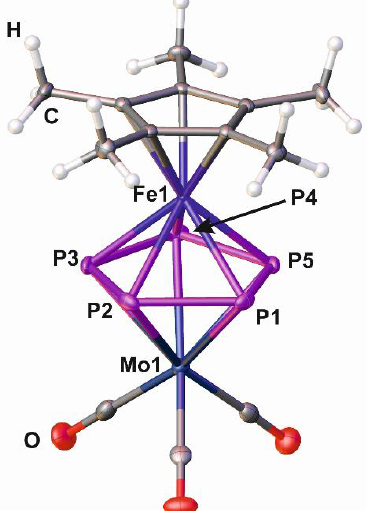
Figure 1. Molecular structure of 2’ in the solid state. Selected bond lengths [Å ] and angles [°]: Fe1 –